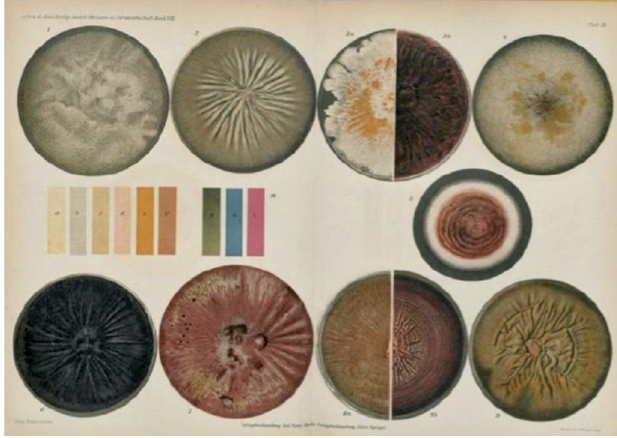
Fig. 3: Several Fusarium species after four weeks of different culture media (image taken from A ppel and W ollenWeber , 1910). 1. Fusarium solani , 2. F. orthoceras , 3a. F. subulatum on Agar No. 42 with orange colored conidia on pale aerial mycelium, 3b. F. sub- ultum on Agar No. 46 with dark red thallus depicted from below, 4 . F. willkommii , 5. F. subulatum , juvenile stage of the culture from 3b, 6. F. coeruleum , 7. F. discolor , 8a. F. metachroum on Agar No. 42 with orange colored conidia, 8b. F. metachroum on Agar No. 46 with dark red submerged thallus, 9. F. finely powdered, dar- ker colored conidia on ochre colored, wrinkled